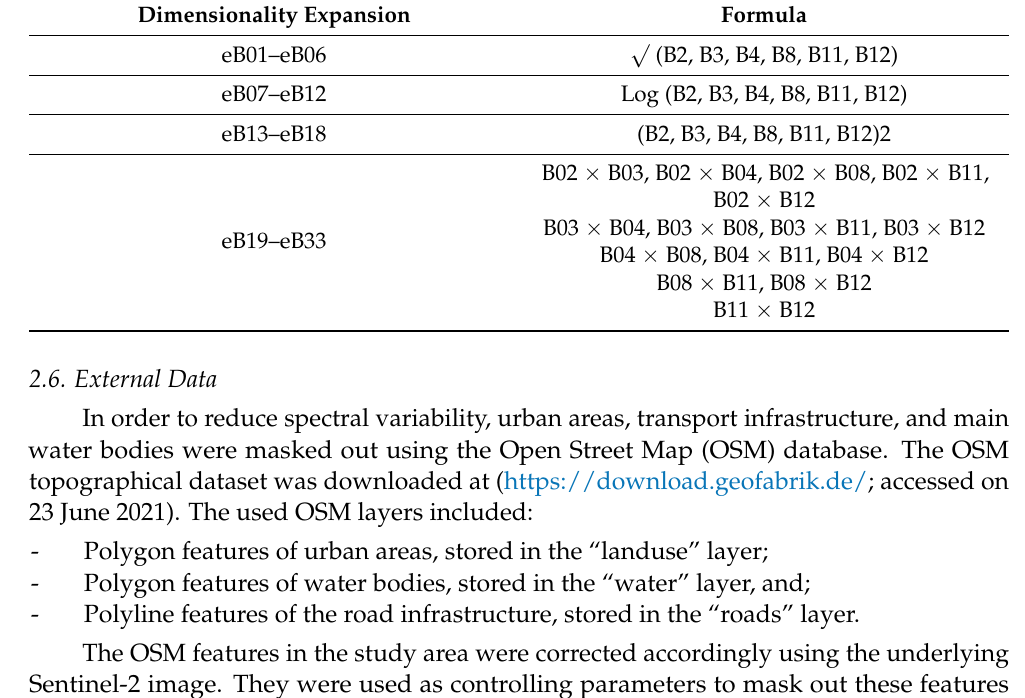
Table 2. Dimensionality expansion for Sentinel-2 multispectral imagery (